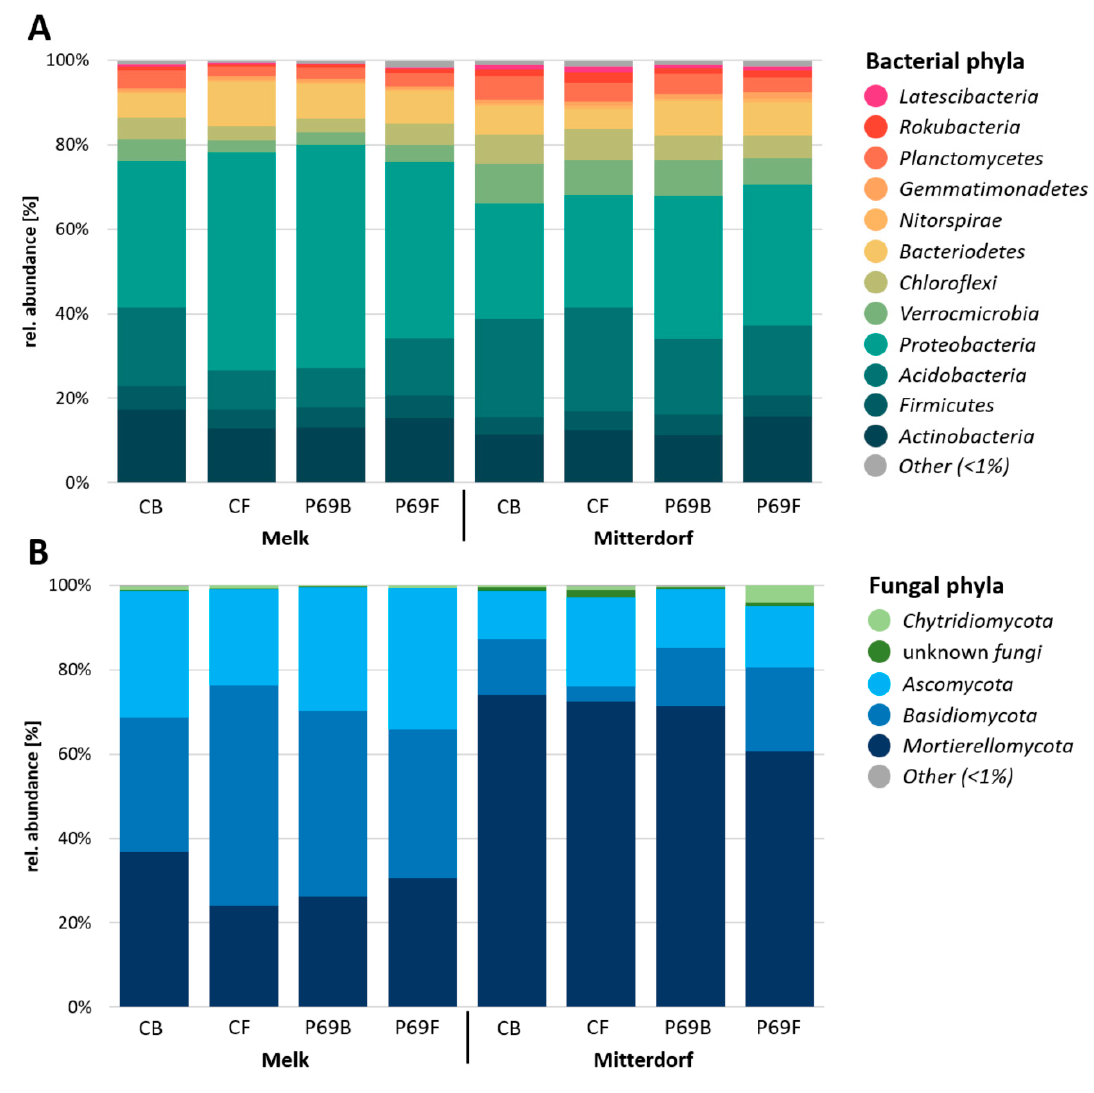
Figure 4. Microbial response in the rhizosphere after seed treatment. Bacterial ( A ) and fungal ( B ) relative taxonomic composition on phylum level is shown for individual treatments.